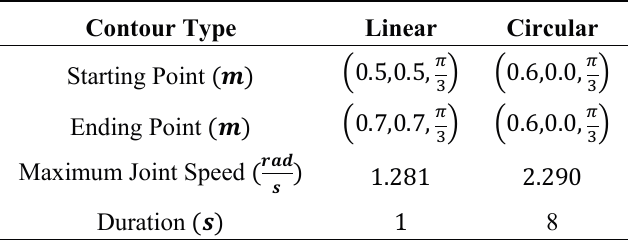
Table 3. Simulation contours.